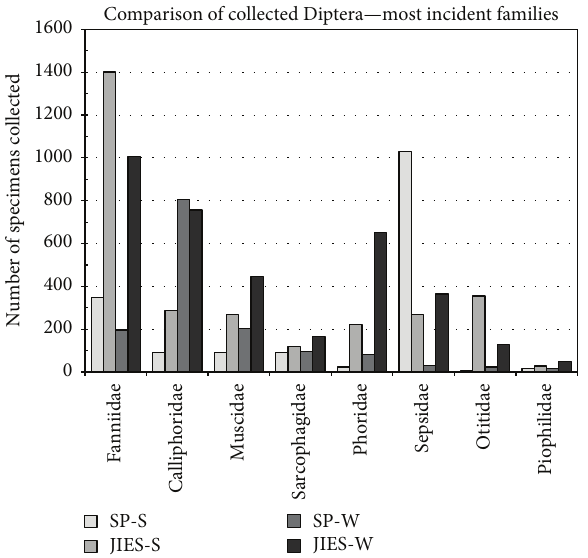
Figure 5: Graphical comparison of the collected Diptera from the families of forensic interest. SP-S: summer experiment, S˜ao Paulo. SP-W: winter experiment, S˜ao Paulo. JIES-S: summer experiment, Peru´ıbe. JIES-W: winter experiment,